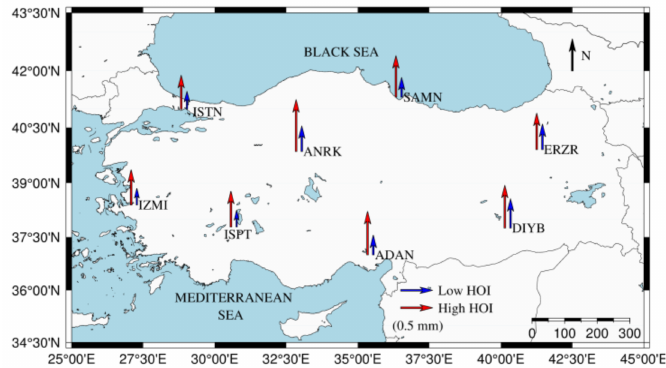
Figure 7. RMS of ZTD di ff erences on low (days 18–24) and high (days 317–323) solar activity days.